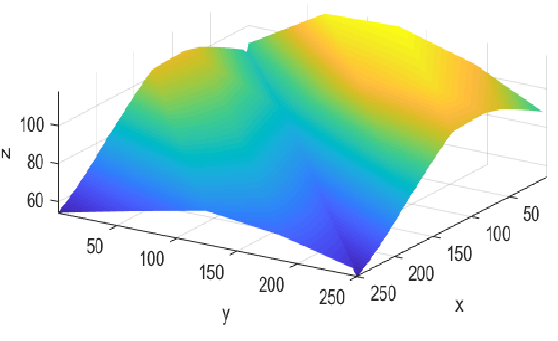
Figure 9. 3D terrain of Bijia